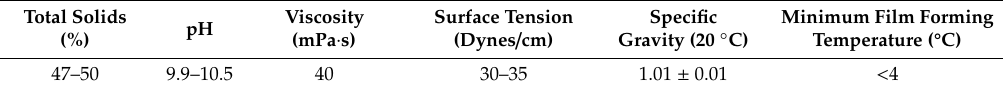
Table 1. Properties of SBR latex.